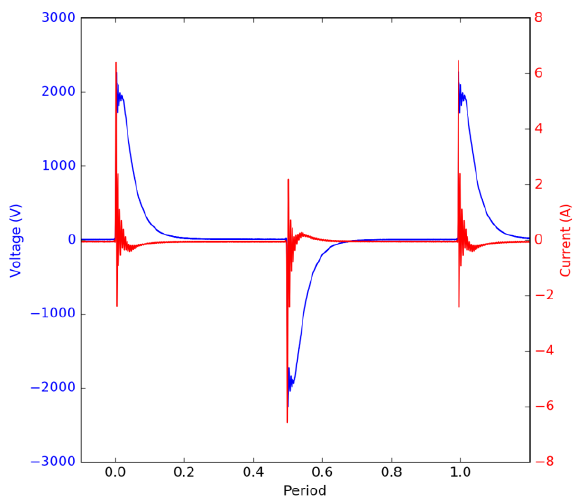
Figure 8. Electric measurements on Planilum lamp (20 kHz-2000 V) for pulse power supply .